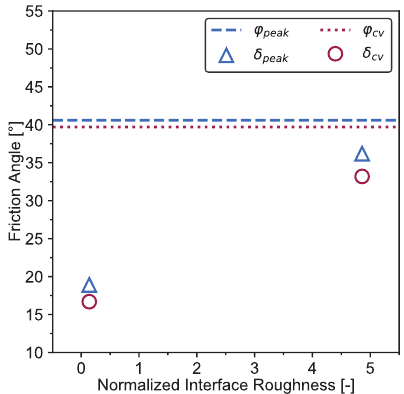
Figure 11. Interface friction angles as a function of normalized interface roughness, compared to internal friction angles of JEZ-1.